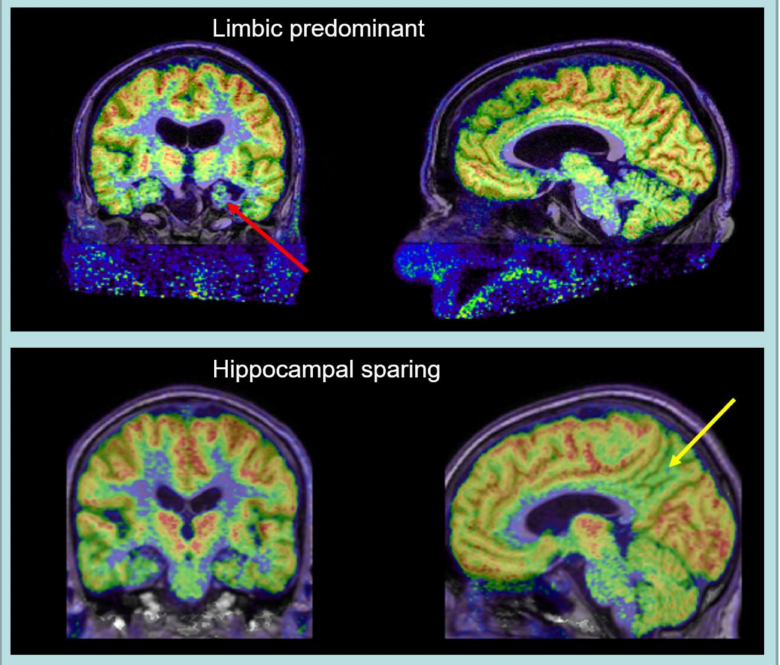
Figure 1. FDG PET with fusion overlay on T1-weighted MR, demostrating hippocampal hy- pometabolism and atrophy (red arrow) in limbic-predominant AD ( top ) and impaired parietal hypometabolism (yellow arrow) in a hippocampal-sparing AD ( bottom ). Both cases show metabolic impairment of posterior cingulate